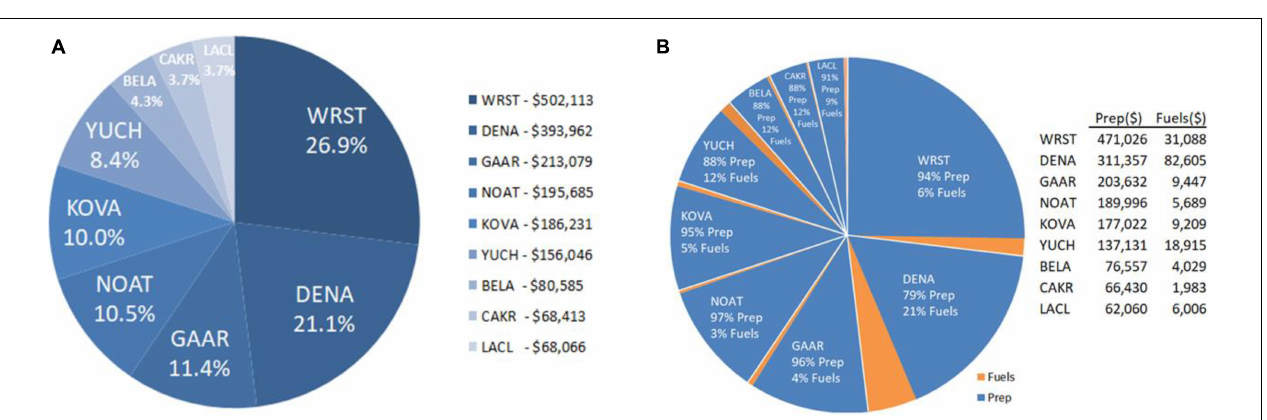
allocate to each park. This scenario has been re-rendered from Figure 7 into Figure 8 to represent this budget “slice.” Using this information, the budget officer is quickly provided with guidelines on how to allocate the total appropriated budget to each of the nine parks. This example shows WRST and